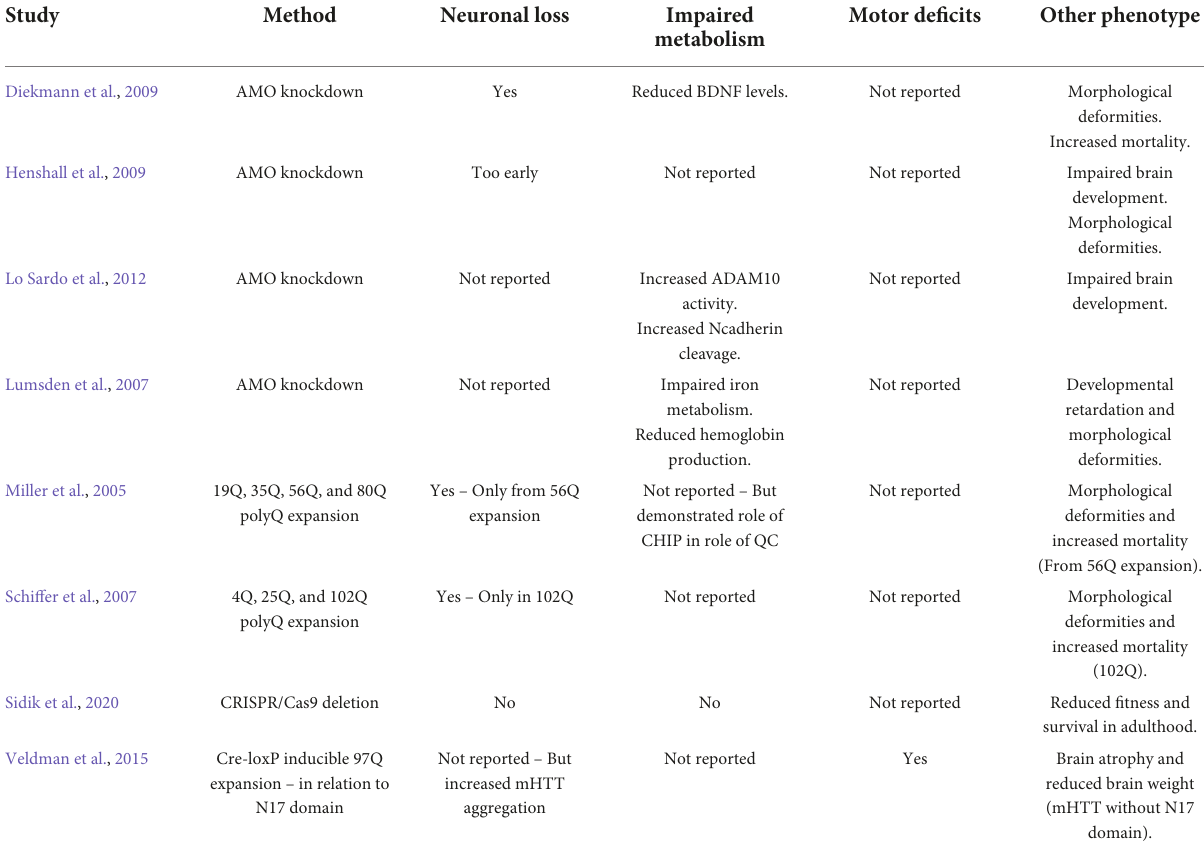
TABLE 9 Zebrafish models of huntingtin